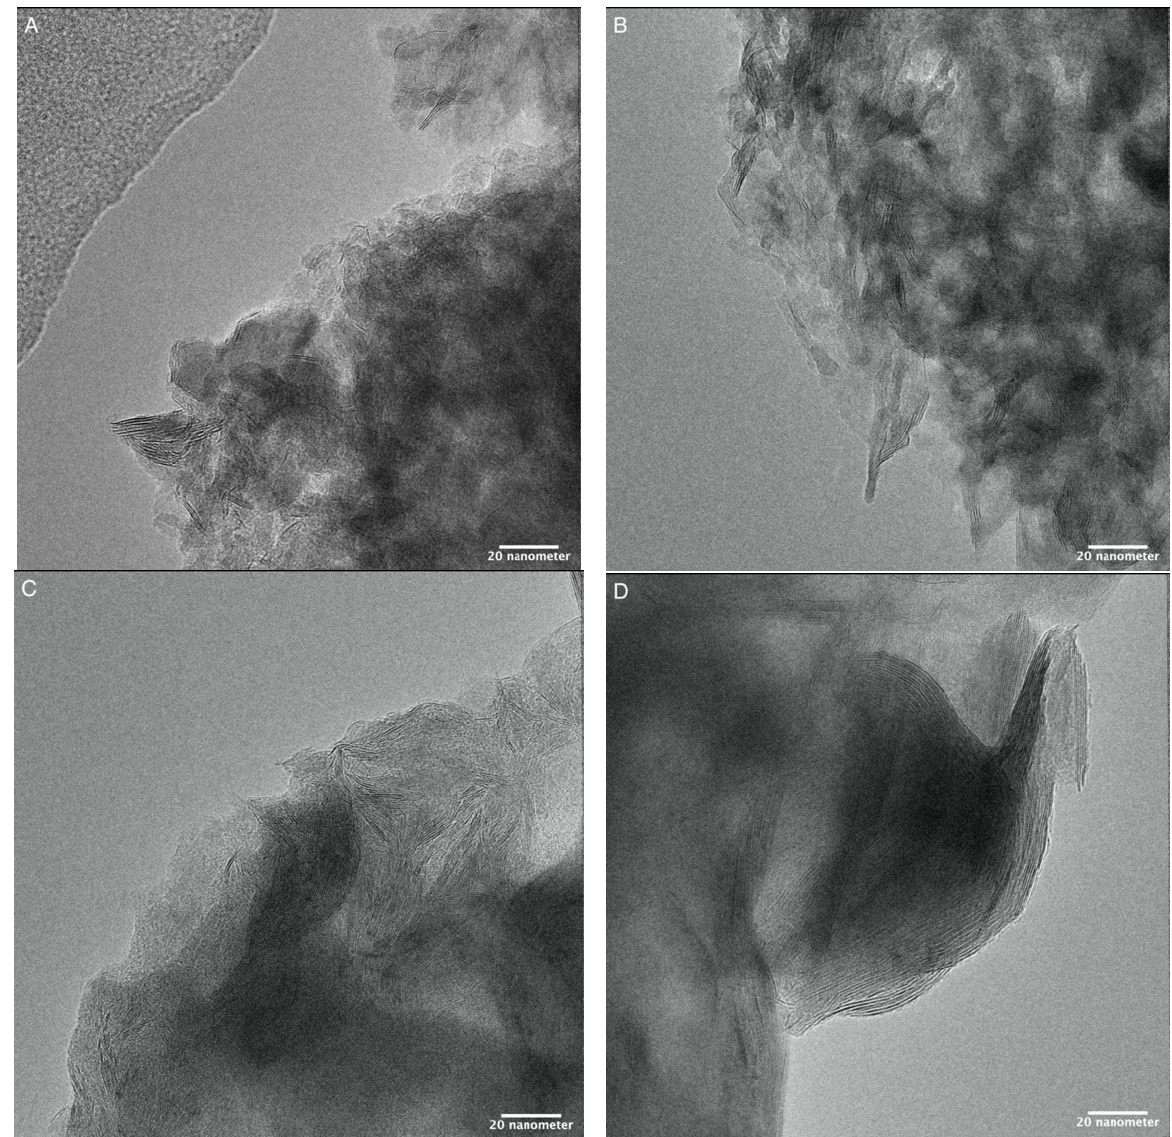
Figure 1. Representative TEM images of the four catalysts. ( A ) Cat-Al 2 O 3 ; ( B ) Cat-CCA; ( C ) Cat-AG-3; ( D ) Cat-BAW.